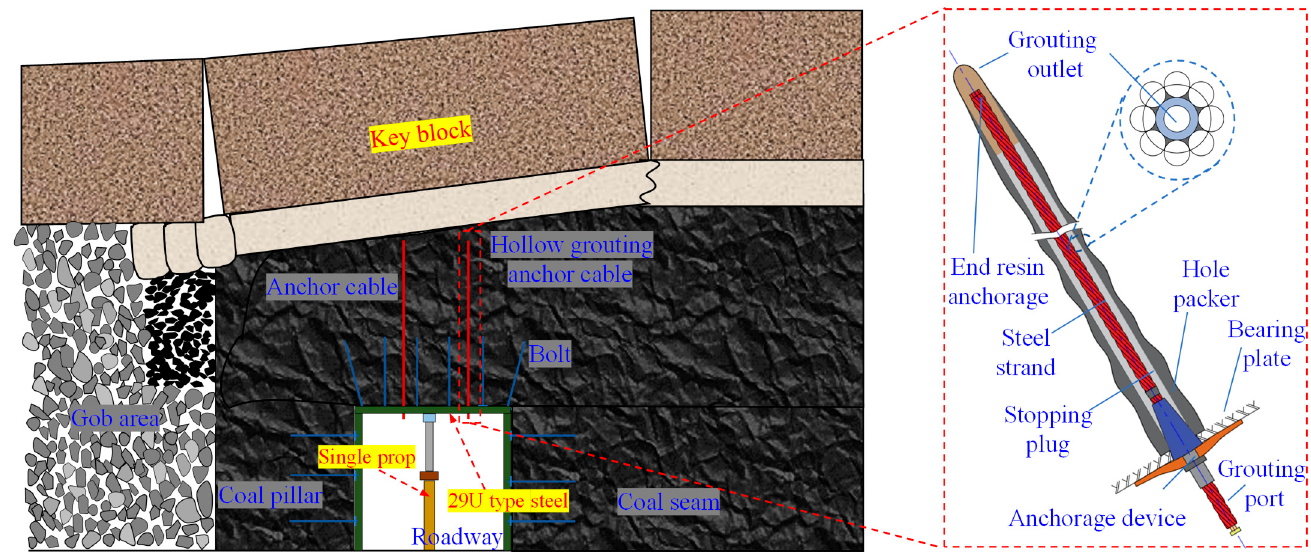
Figure 25. Shed support-grouting anchor cable cooperative support diagram [33].